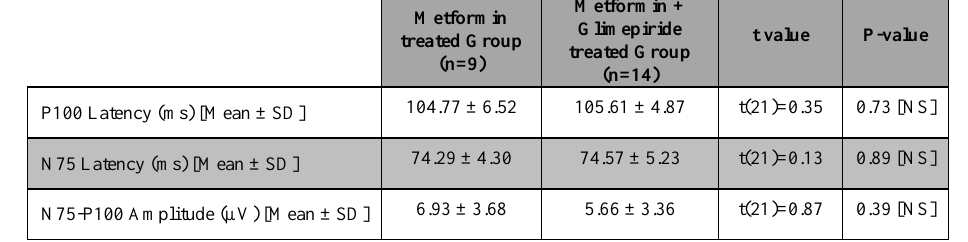
Table 16. Comparison of average VEP wave latencies and the average amplitude of both eyes between only metformin-treated and both metformin and glimepiride treated group of diabetic patients.